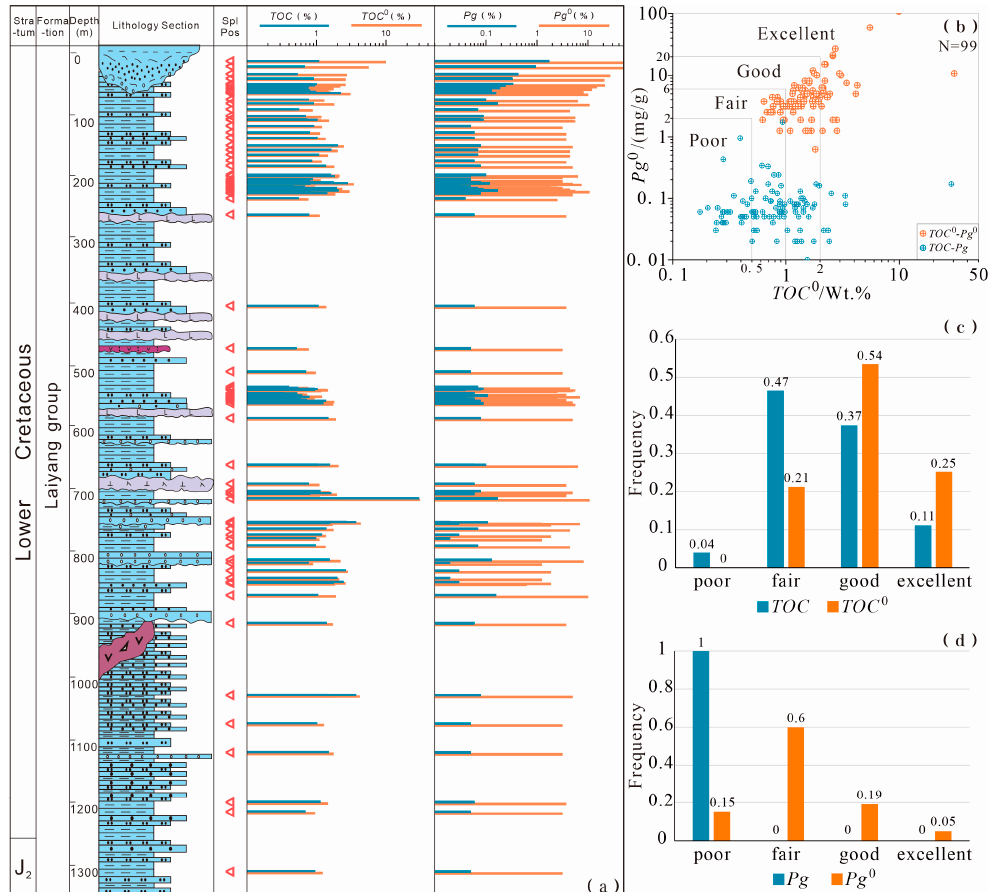
Figure 5. Restoration of TOC 0 and Pg 0 and comparison with TOC and Pg of well LK-1 source rock: ( a ) TOC 0 and Pg 0 recovery diagrams residual; ( b ) the cross and comparison plot of Pg and TOC - Pg 0 and TOC 0 ; ( c ) histograms of organic-matter abundance frequency of TOC and TOC 0 ; and ( d ) histograms of organic-matter abundance frequency of Pg and Pg 0